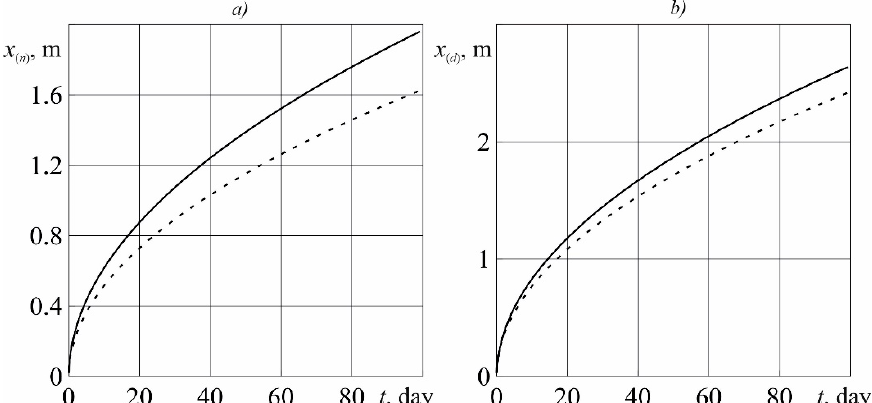
Figure 3. Comparison of numerical solutions (solid curve) and approximate analytical solutions (dashed curve). ( a )—the coordinate of the near boundary of phase transitions; ( b )—the coordinate of the far boundary of phase transitions.